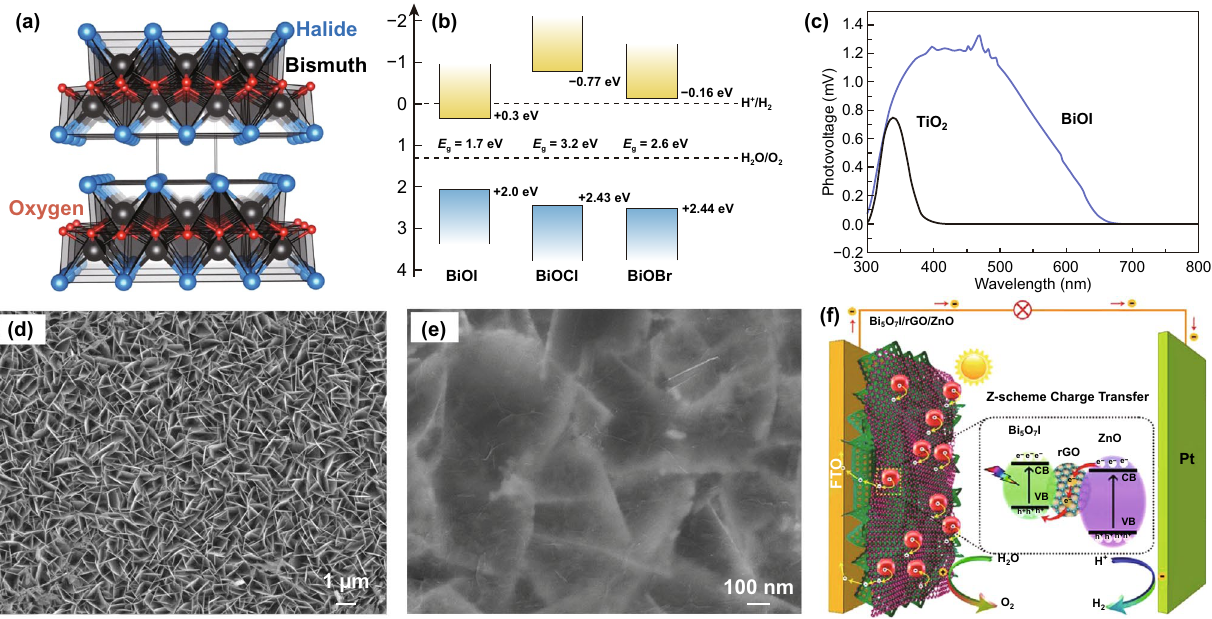
Fig. 10 a Crystal structure of bismuth oxyhalide systems, b band alignments of BiOX at pH = 0, c surface photovoltaic spectroscopies of BiOI and TiO 2 , d, e SEM images of porous Bi 5 O 7 I and Bi 5 O 7 I/rGO/ZnO, f scheme of charge transfer mechanism of Bi 5 O 7 I/rGO/ZnO. Reproduced with permission from Ref. [173, 175, 179]. Copyright 2016 Royal Society of Chemistry, Copyright 2009 and 2019